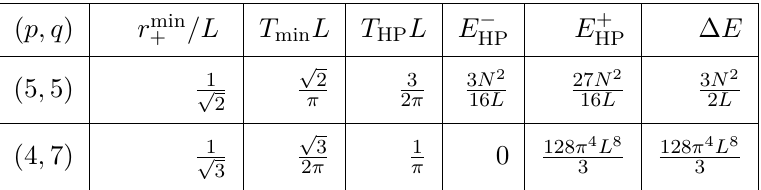
Table 1. Relevant thermodynamic values in the phase diagram of the solutions preserving the background’s isometries. In D = 10 , the G has been expressed in terms of the dual gauge theory 10 parameter N using (4.1). In D = 11 , G is a fundamental constant and can be taken to be 11